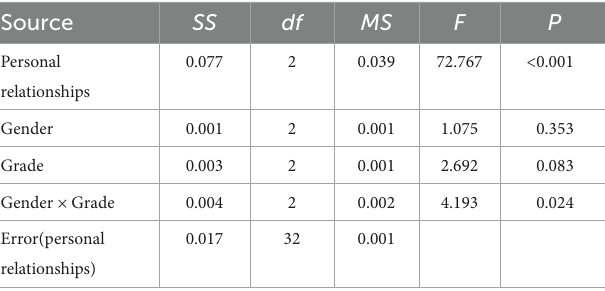
TABLE 9 Results of the intra-group factor